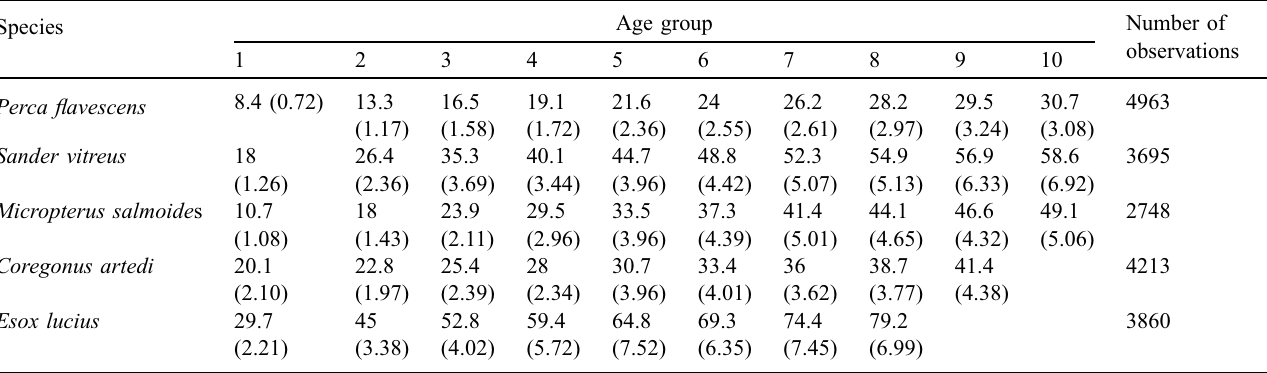
Table 1. Mean total length (cm) and standard deviations (in brackets) by age group and number of observations for fi ve freshwater fi sh species. Species Age group